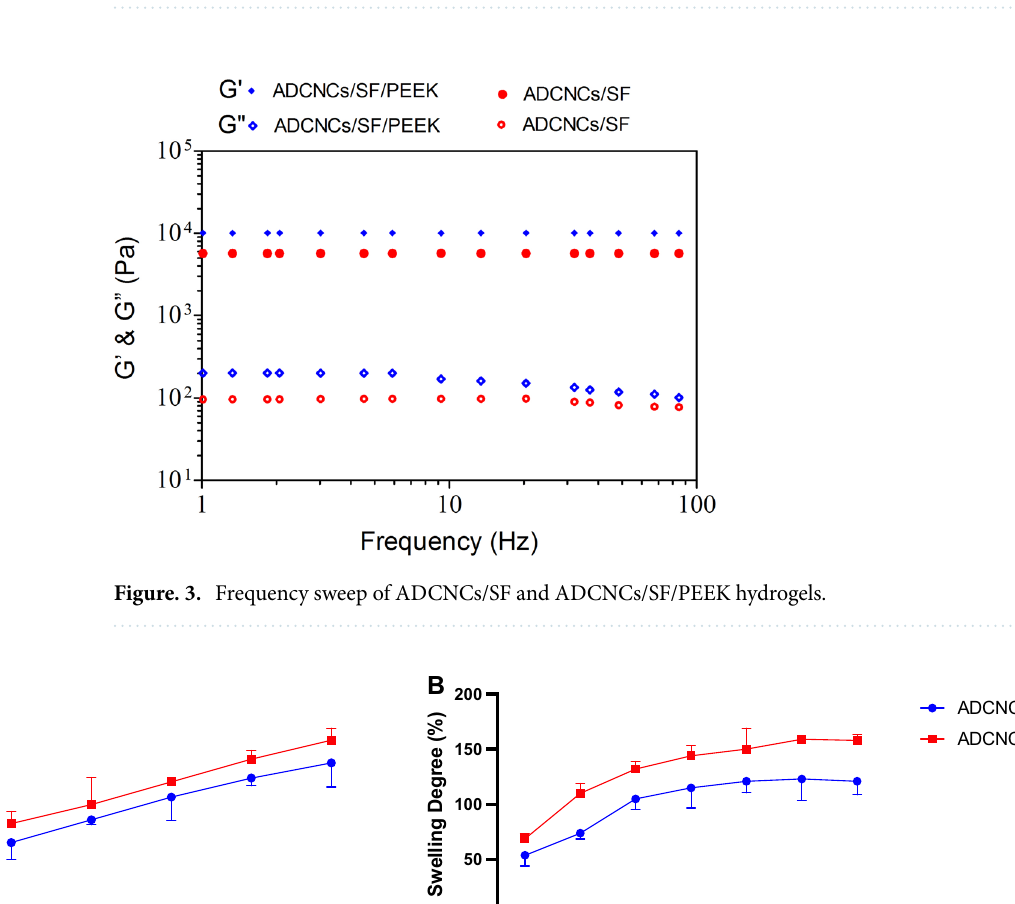
Figure 2. TGA curves of ADCNCs/SF and ADCNCs/SF/PEEK.